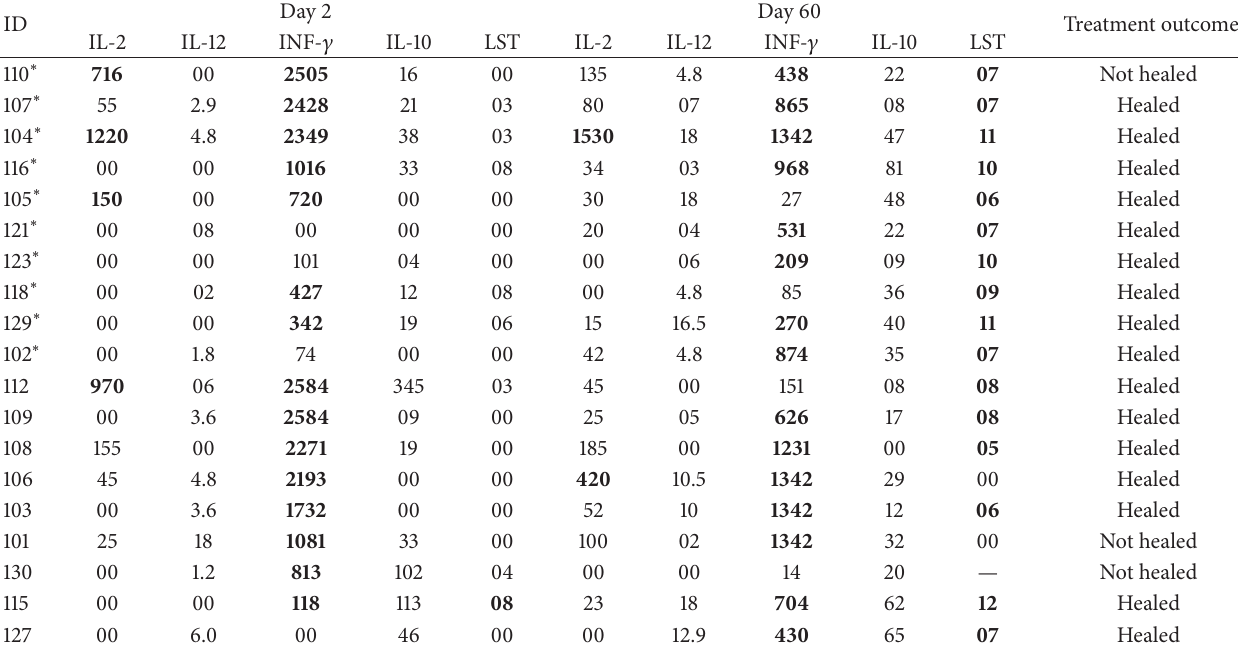
∗ Group I patients (SSG + vaccine). IFN- 𝛾 , IL-2, Il-12, and IL-10 levels are expressed in pictogram/mL; leishmanin skin test (LST) induration is expressed